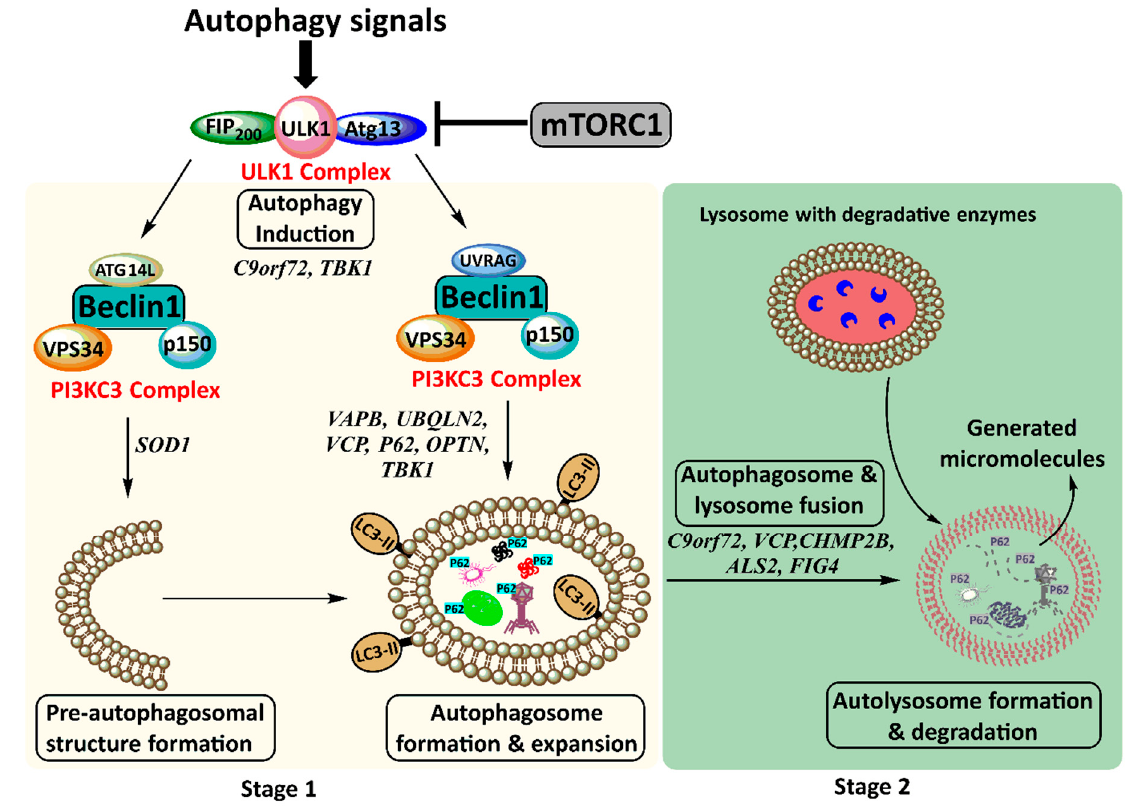
Figure 2. The two main stages of the autophagy pathway. Stage 1 involves autophagy induction where autophagy signals result in the formation of the Unc-51 like autophagy activating kinase 1 (ULK1) complex followed by the phosphatidylinositol 3-kinase class 3 (PI3KC3) complex. This leads to pre-autophagosomal structure formation and autophagosome formation and expansion. Stage 2 involves autophagosome transport for fusion with lysosomes. This leads to autolysosome formation and degradation of its contents. ALS-associated proteins that impair autophagy are indicated beside each step of the pathway. FIP200, FAK family kinase-interacting protein of 200 kDa; mTORC1, mammalian target of rapamycin complex I; ULK1, Unc-51 like autophagy activating kinase 1; p150 / Vps15, vacuolar protein sorting 15; Vps34, vacuolar protein sorting 34; LC3-II, C-termini of microtubule-associated protein 1A / 1B-light chain 3B; UVRAG, UV radiation resistance associated; Atg13, autophagy-related protein 13; Atg14L, autophagy-related protein 14.